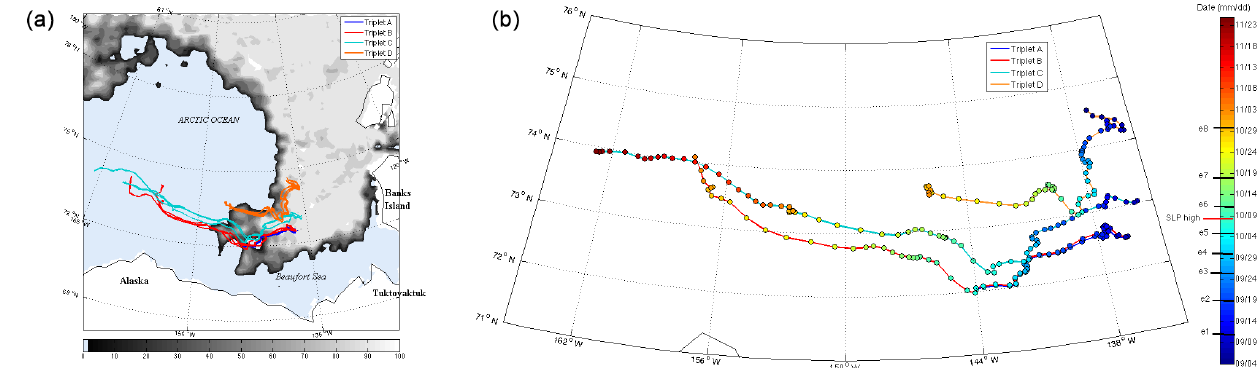
Figure 1. GPS buoy-array-triplet trajectories relative to sea ice and coastline. Trajectories for beacons deployed near 135 ◦ W between 72 ◦ N and 75 ◦ N capture spatiotemporal evolution in ice beacon triplet centroids beginning in September 2009, with triplet A located closest to, and triplet D located furthest from, the continental coastline. Triplets A and B, deployed near 72 ◦ N, share two of the three beacons and are advected westwards to approximately 144 ◦ W and 158 ◦ W, surviving until 7 October and 5 November, respectively. Triplet C is deployed near 73 ◦ N and is also advected westward to 162 ◦ W, surviving until 26 November. Triplet D is deployed near 74.5 ◦ N and traverses a shorter path southwards and westwards to 145 ◦ W, surviving until 4 November. (a) Evolution in triplet A to D centroid trajectories, superimposed on sea ice concentration map in early September 2009 on triplet deployment. Triplet D is also initially located nearest the tongue of multiyear ice edge. (b) Temporal evolution of triplet centroids A to D, colour-coded by date with each directional change event enumerated in the colour bar timeline. The sea level pressure (SLP) high, resulting in strong offshore ice drift, and decoupling in ice–atmosphere interactions is also